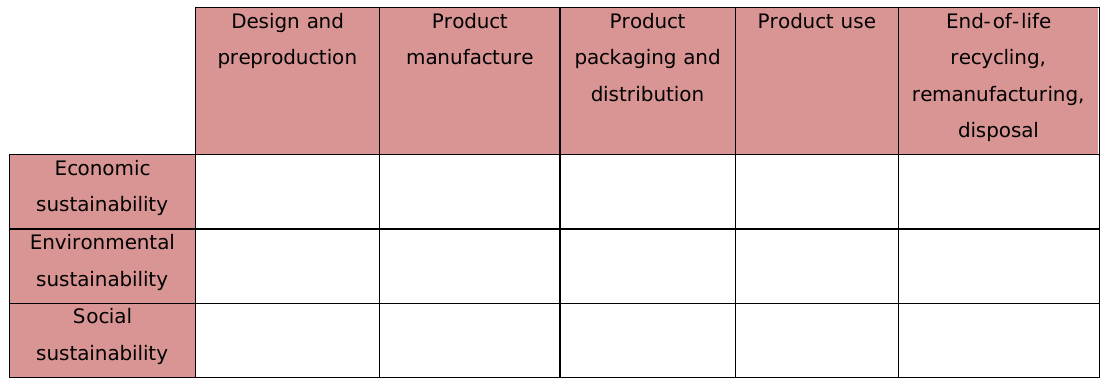
Figure 2. “Life cycle stages and CSR dimensions”. Source: